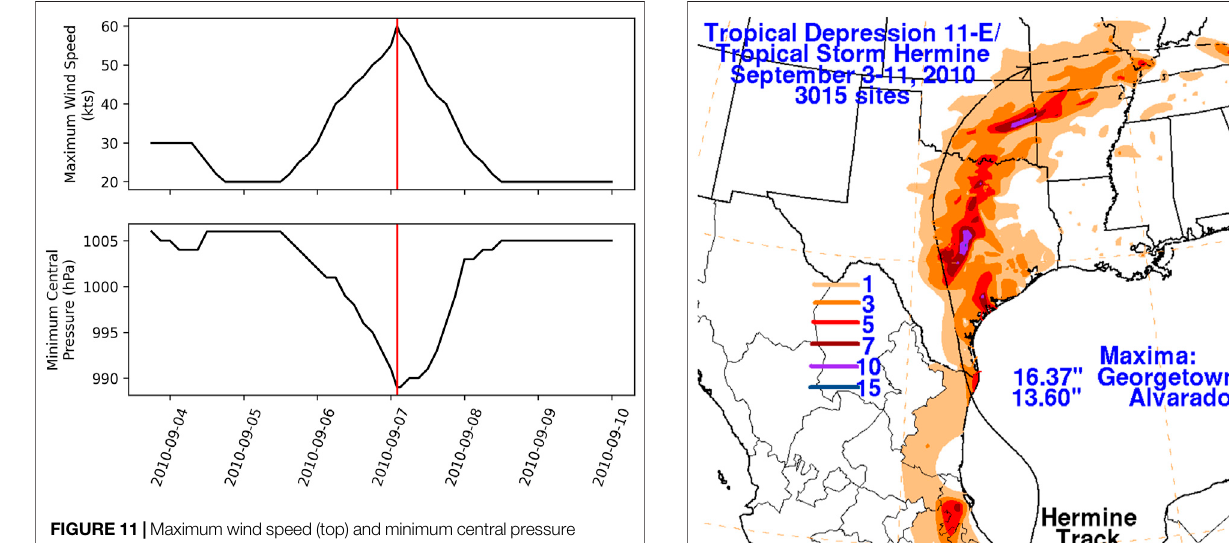
FIGURE 11 | Maximum wind speed (top) and minimum central pressure (bottom) for Tropical Storm Hermine (2010). The red line depicts landfall.